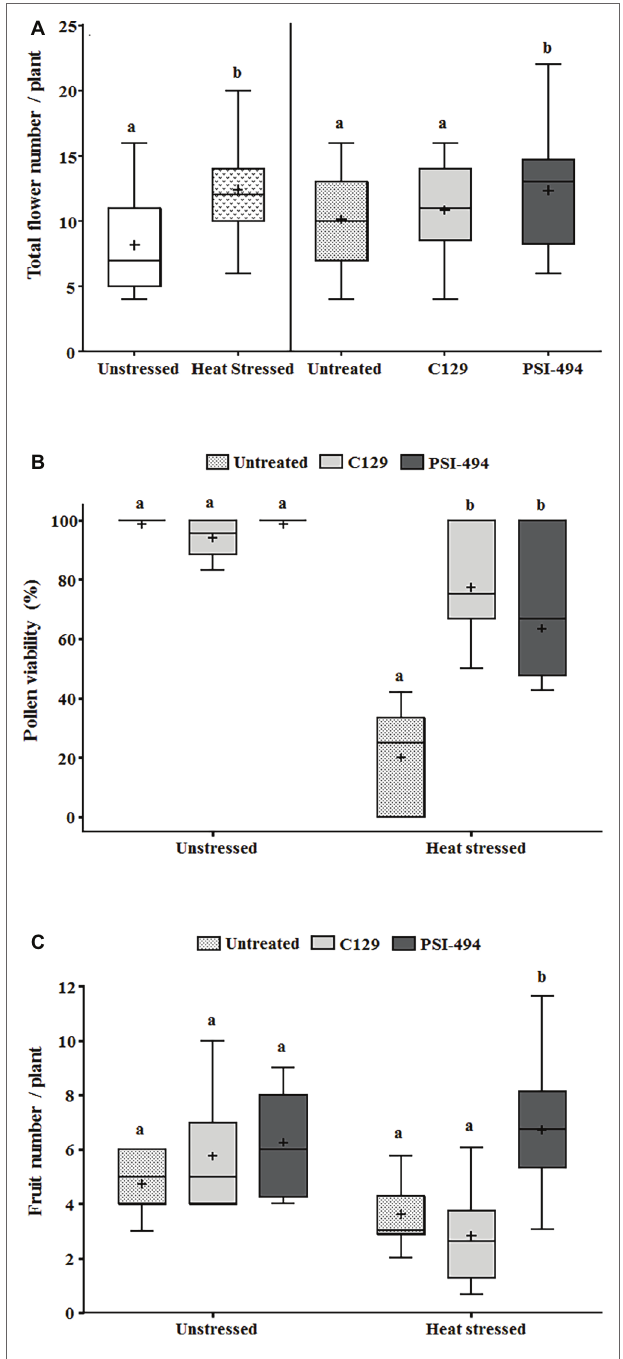
FIGURE 3 | Effect of heat stress and ANEs on reproductive parameters of tomato plants. (A) Total flower number; (B) pollen viability; and (C) fruit number. Total flower number and pollen viability were measured in 122-day- old plants and fruit number in 129-day-old plants. Data were subjected to two-way ANOVA and Tukey’s HSD test for evaluating the differences among means at p ≤ 0.05. Since there was no significant AxB interaction for total flower number, the effect of condition and ANE treatment was evaluated separately, comparing the respective means. Different letters indicate statistical differences for p ≤ 0.05 based on t -test (condition) or one-way ANOVA Tukey’s HSD test (ANE treatment). The vertical line is used to